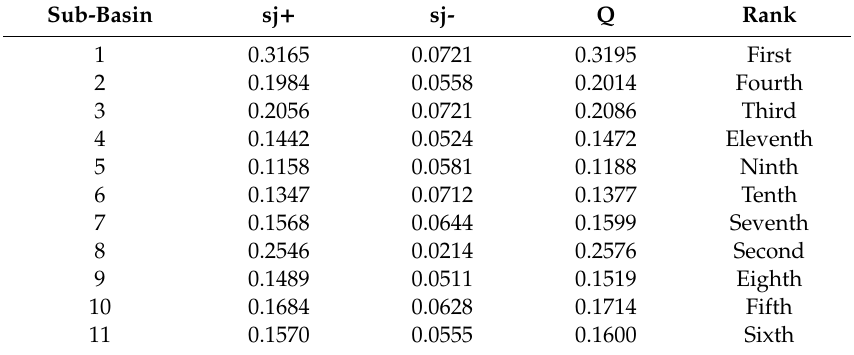
Final weight of sub-basins using complex proportional assessment of alternatives (COPRAS)